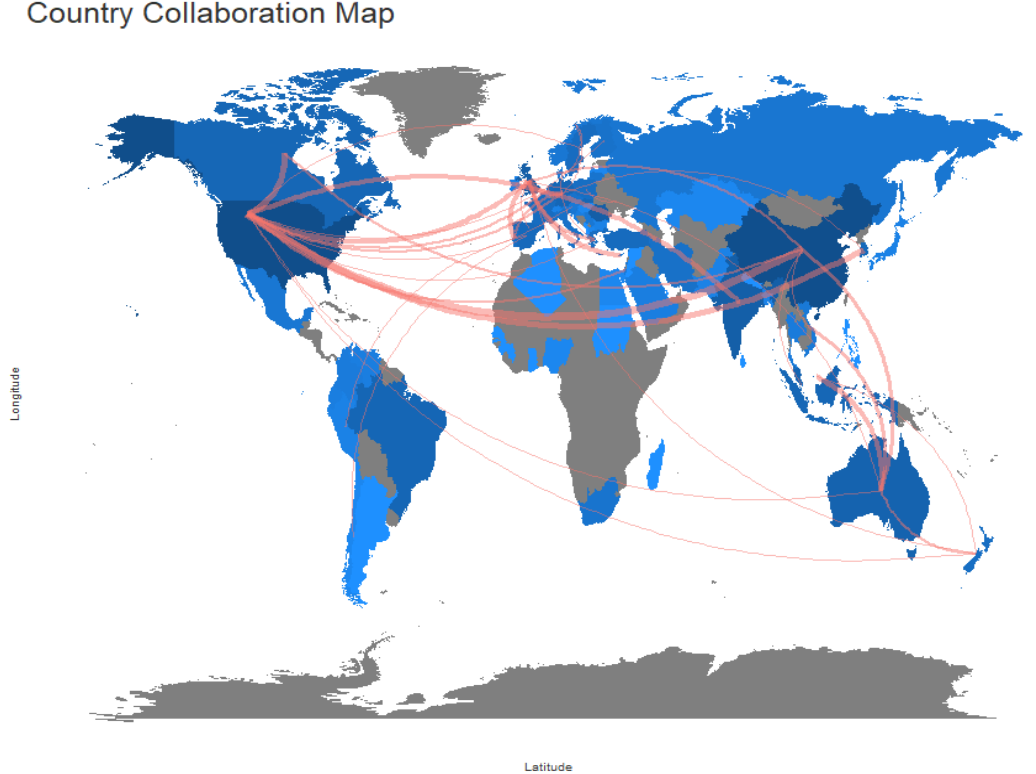
Figure 10. Country collaboration map on green marketing literature.